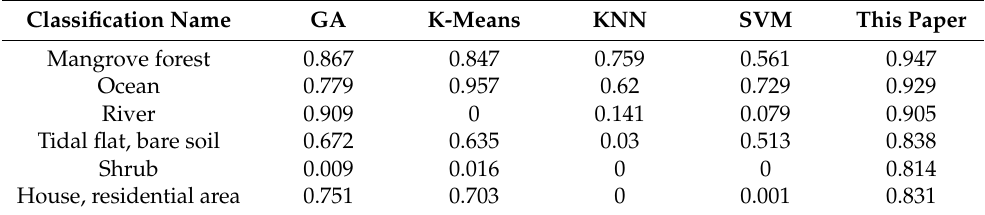
Table 2. Test Results for IoU Parameter (Data 1).